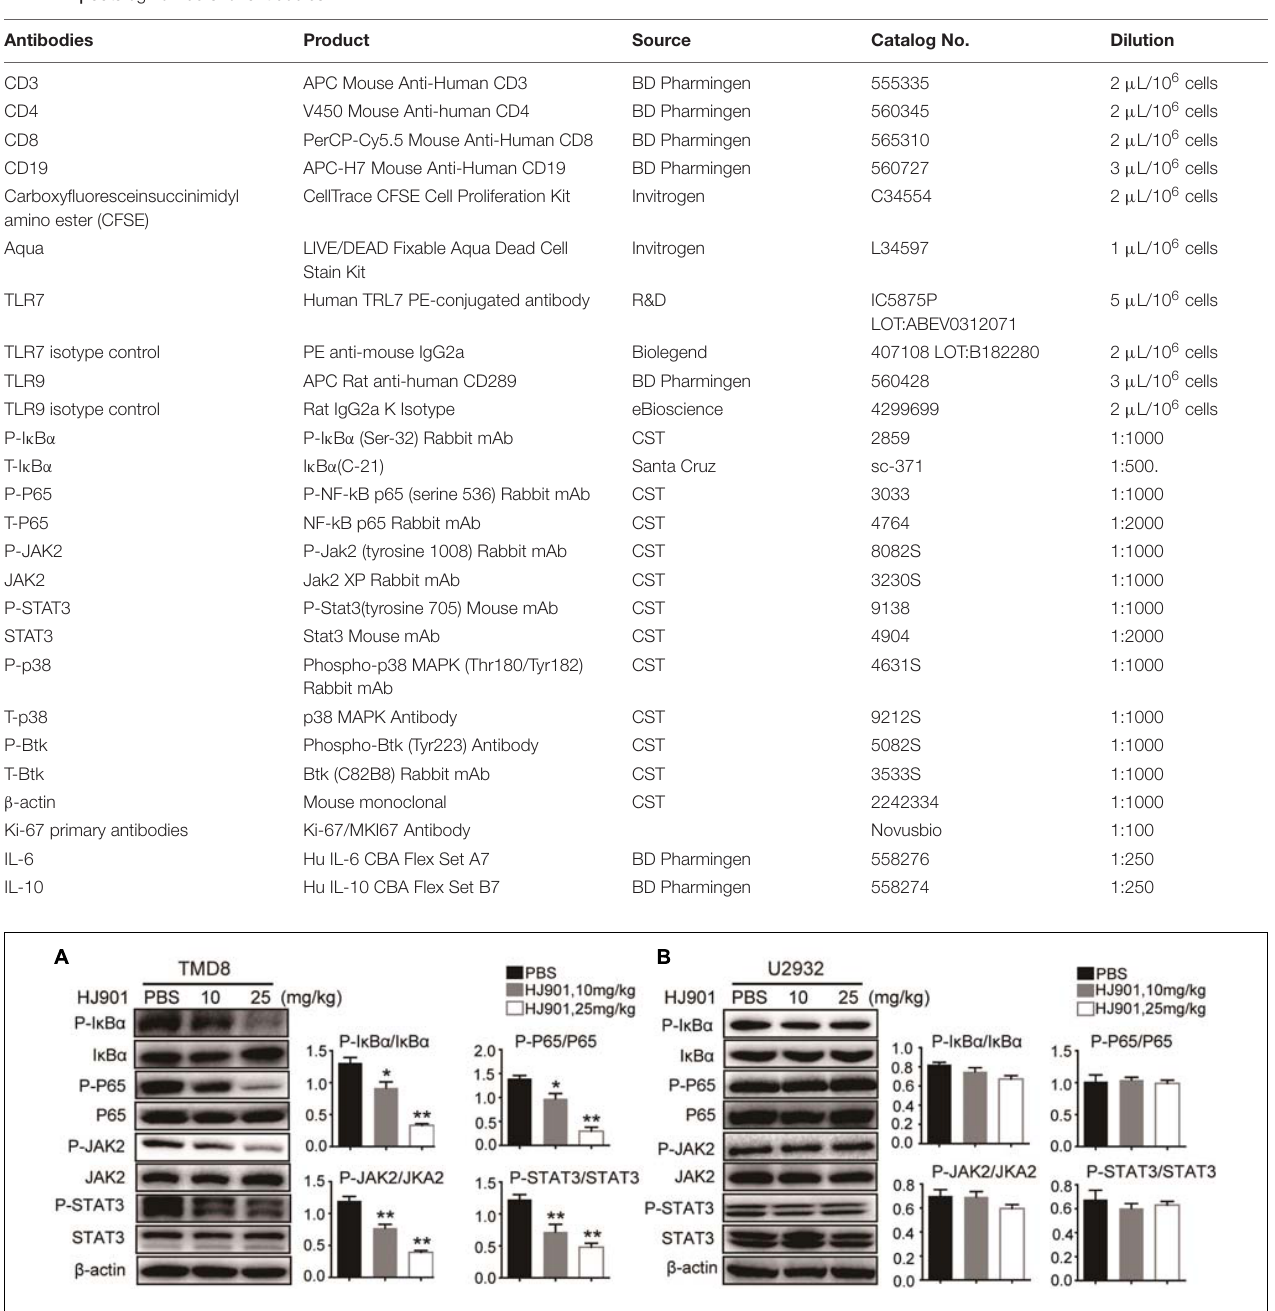
TABLE 1 | Catalog numbers for antibodies.